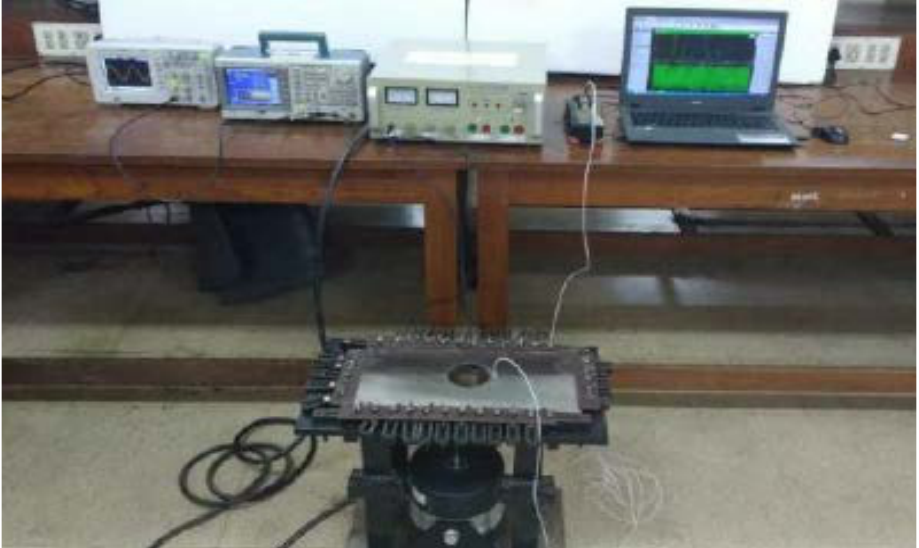
Figure 2: Experimental setup with the fixtures